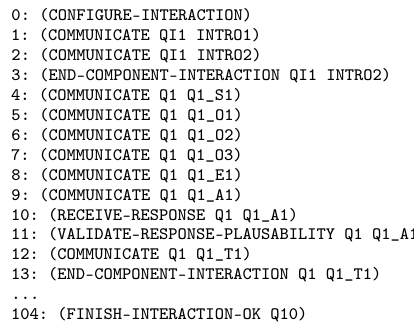
Figure 8. Plan fragment of the nominal plan for the Barthel